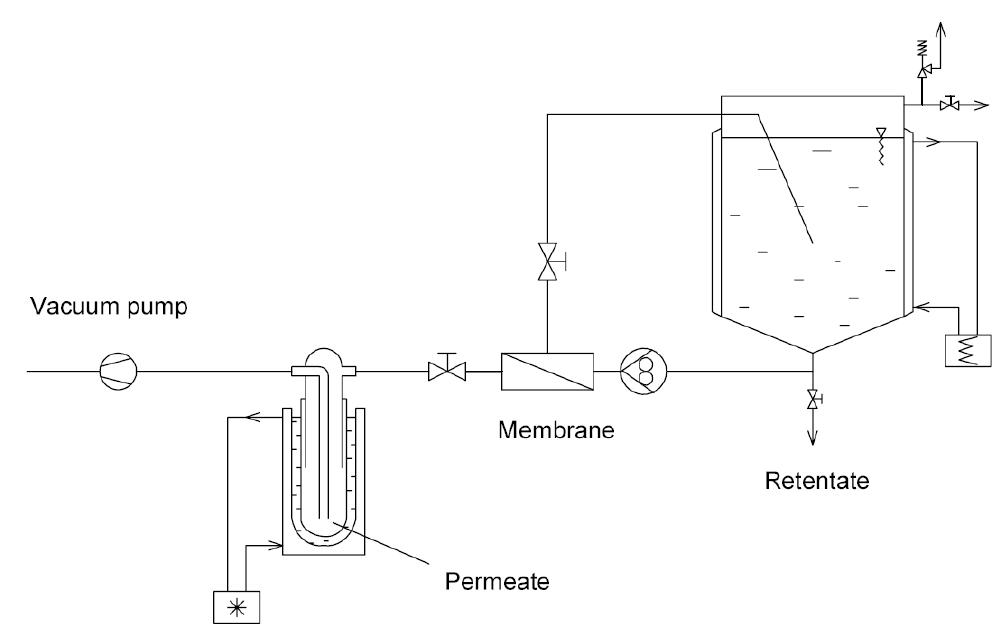
Fig. 3 Laboratory pervaporation system.